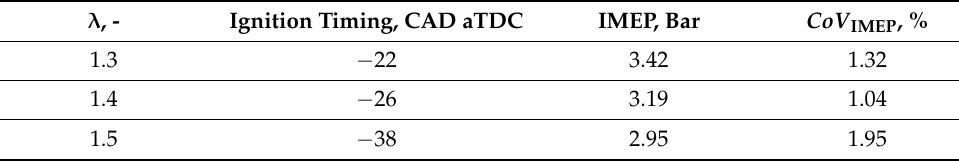
Table 3. Main features of the test campaign used as